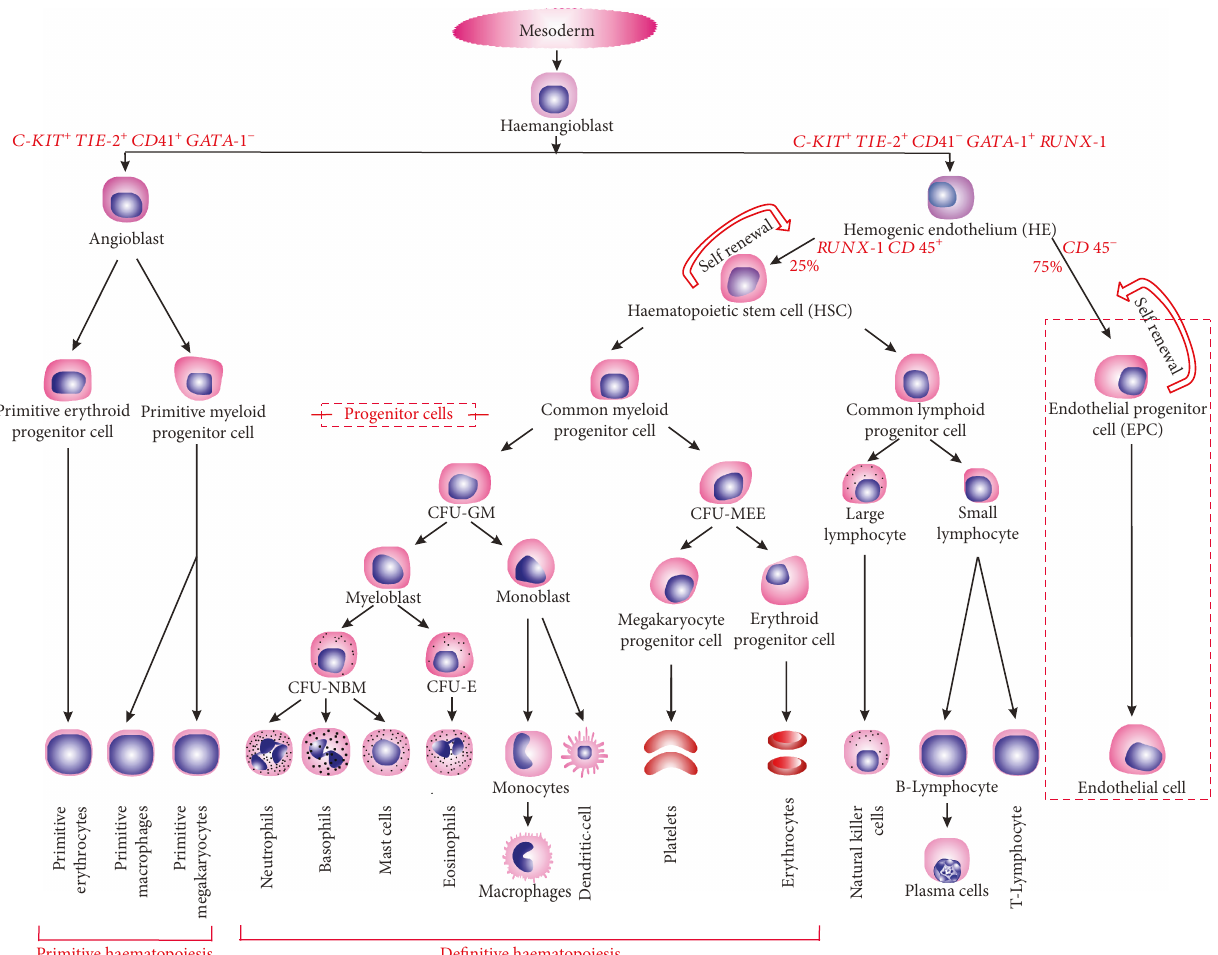
Figure 2: Origin of ECs from haemangioblast: